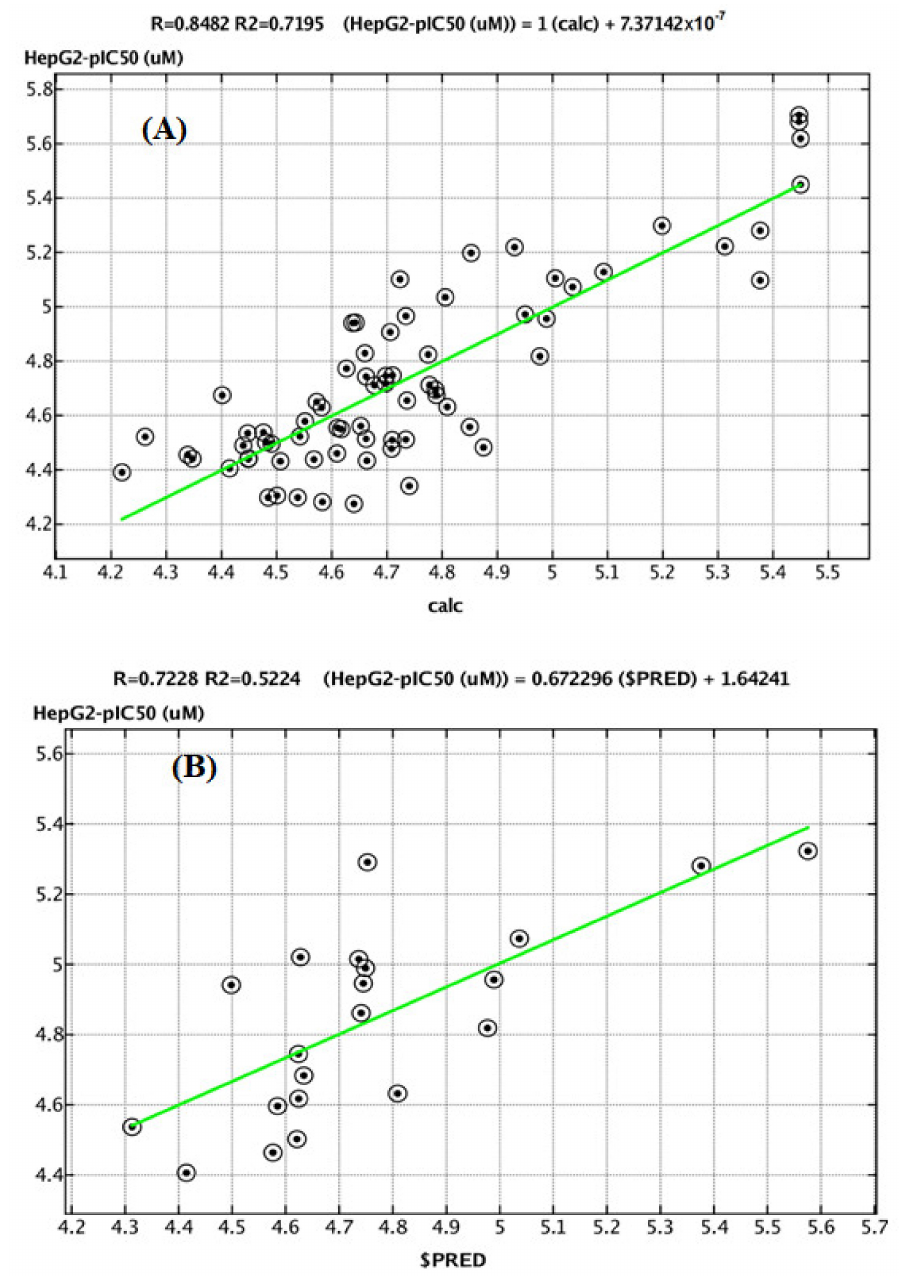
Figure 12. A plot of observed versus predicted pIC50 (HepG2) of the training set ( A ) and testing set ( B